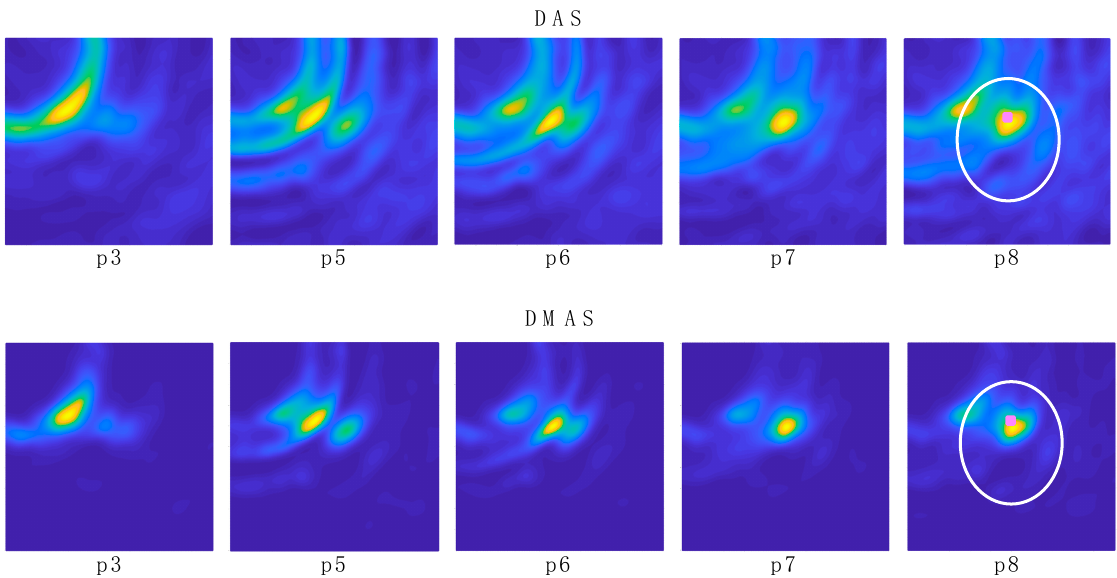
Figure 12. Initial images with DAS and DMAS algorithms.